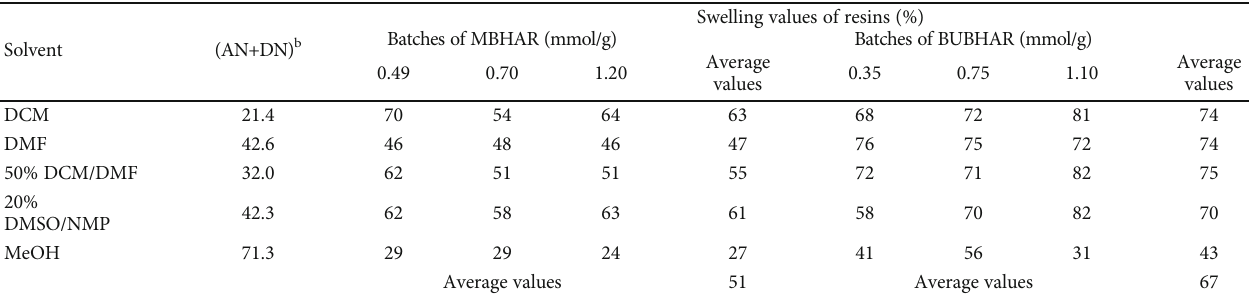
Table 1: Bead swelling a values of methylbenzhydrylamine resin (MBHAR) and 4- tert -butyl-benzhydrylamine resin ( BUBHAR) batches in di ff erent solvent